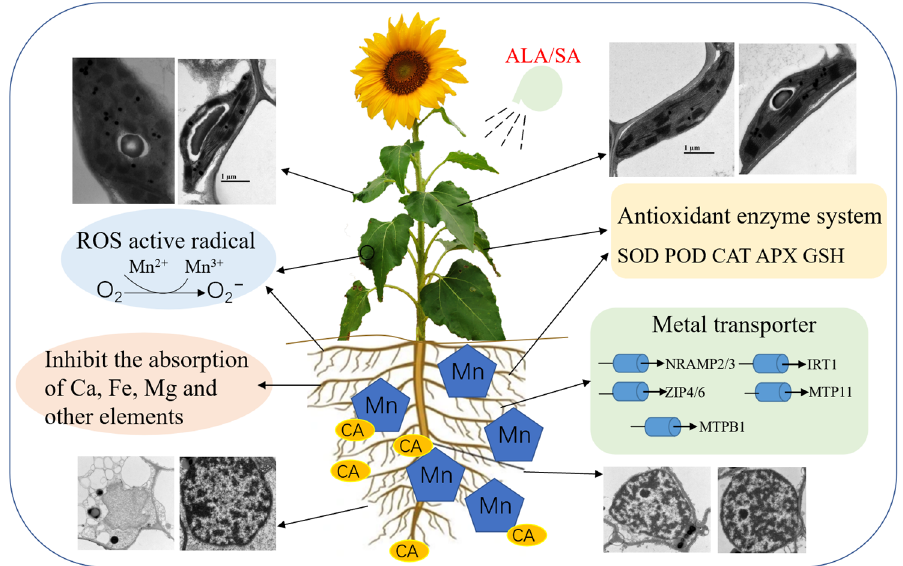
Figure 7. A model figure to illustrate the dual (beneficial/toxic) effects of 5-aminolevulinic acid or salicylic acid (ALA/SA) combined with citric acid (CA) on manganese (Mn)-treated Helianthus an- nuus L.